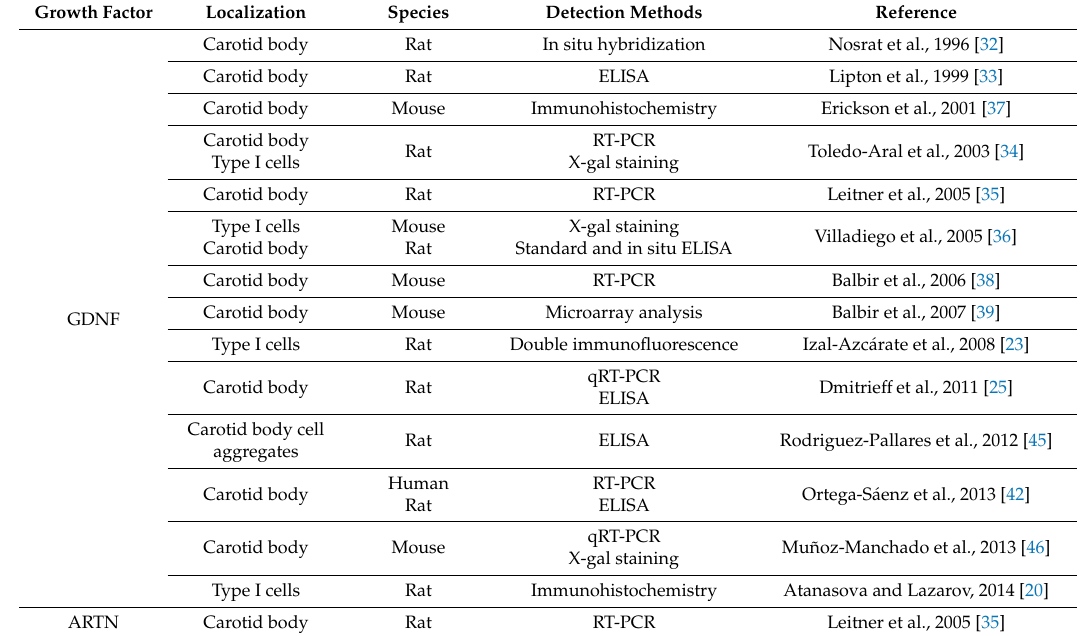
Table 3. Glial cell line-derived neurotrophic factor family. Expression of GDNF and ARTN in the carotid body.